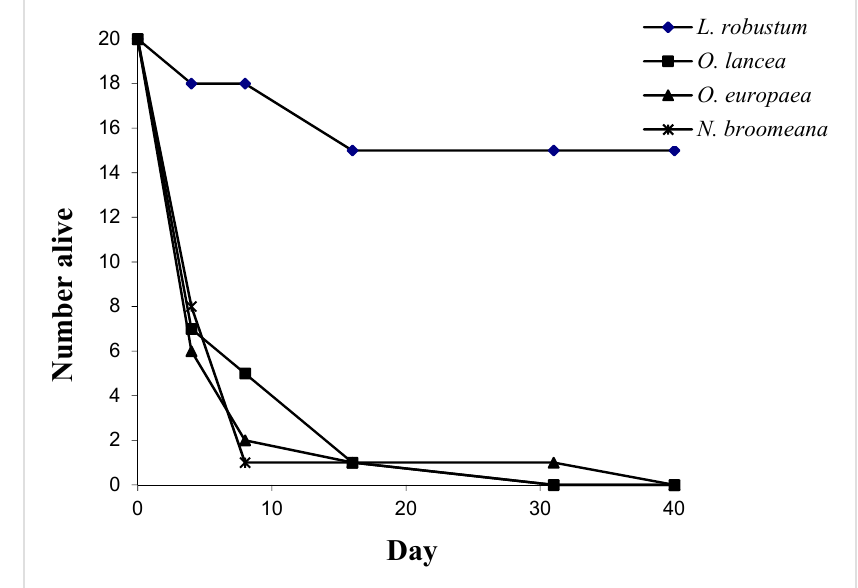
Figure 1. Survivorship curves for 1st instar Epiplema albida larvae feeding on potted key test plants: Olea lancea , O. europaea subsp. africana and Noronhia broomeana , with Ligustrum robustum subsp. walkeri as controls. Table 4. Damage recorded on day 4 in choice tests carried out on Epiplema albida larvae in Petri dishes (for the analysis trace damage was recorded as 0.5 and samples with dead larvae were not included). Mean Damage Score Mean Damage Score Paired t -Test Significance Test Plant Species Replicates Control ( ± SE) Test sp. ( ± SE) (Degrees of Freedom) Ligustrum